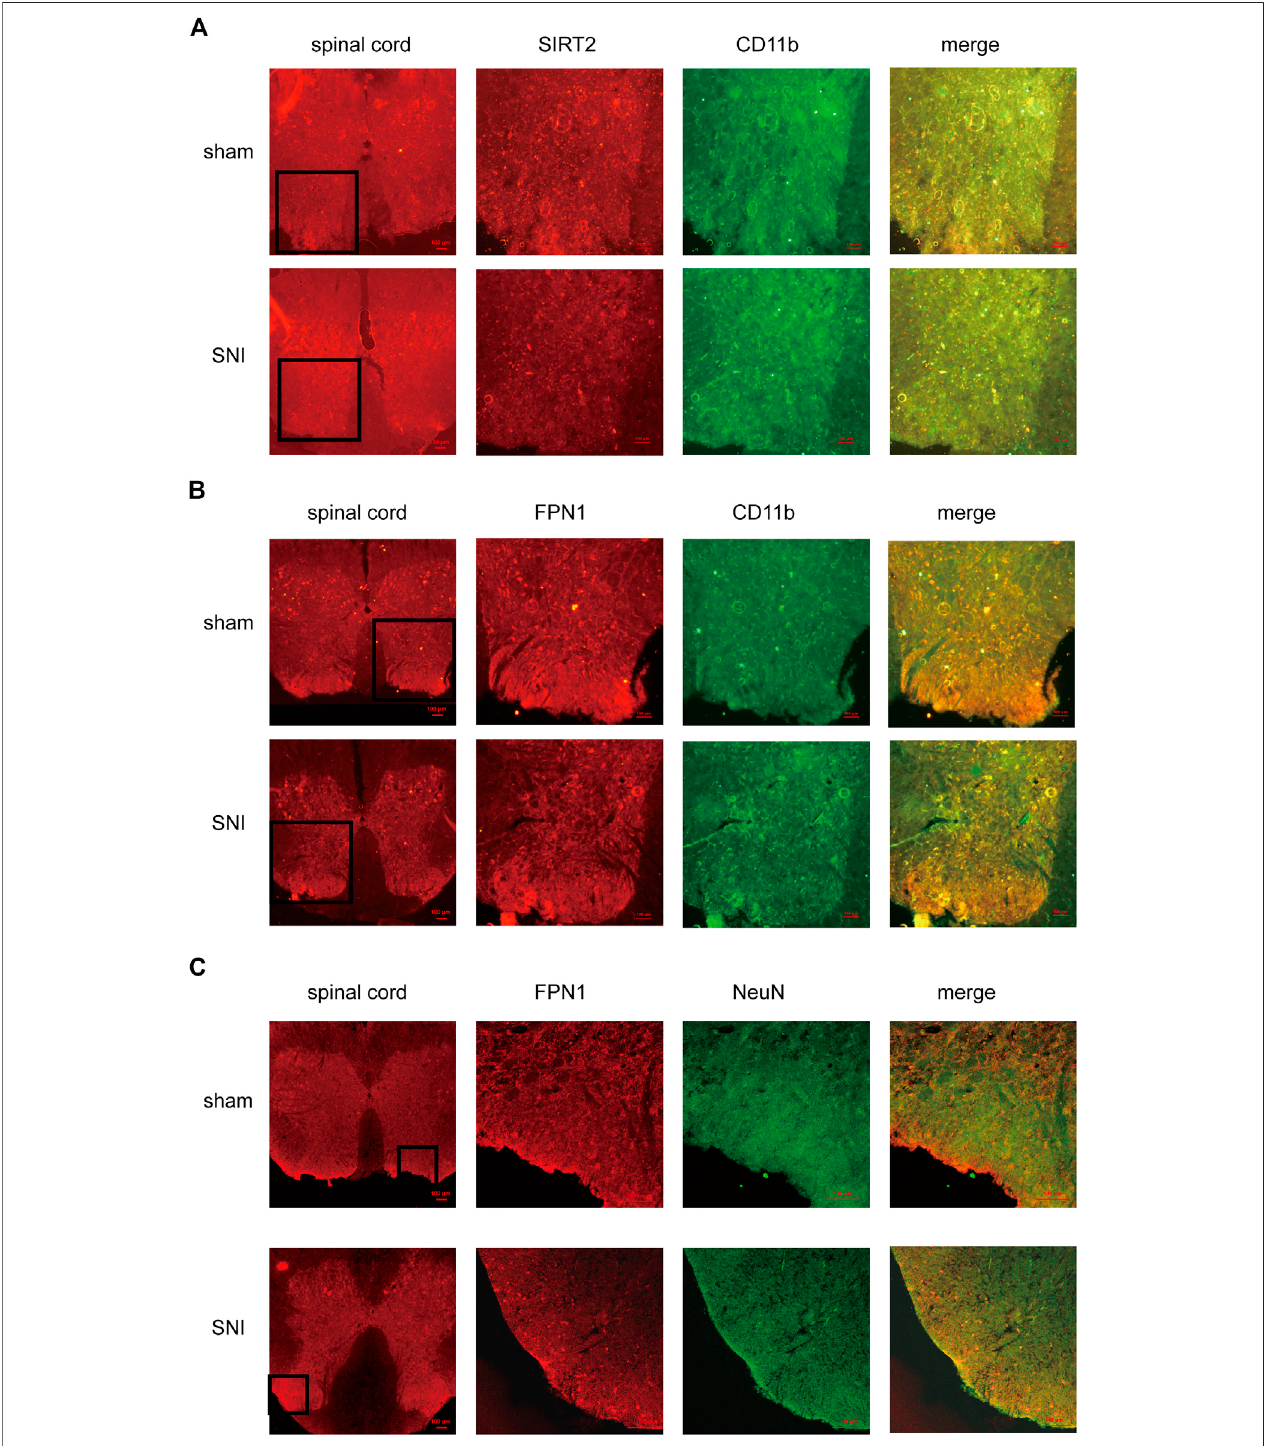
FIGURE3| ThecellularlocalizationofSIRT2andFPN1inthespinalcord. (A) SIRT2levelsdecreasedinthemicrogliaofSNIrats. (B , C) FPN1levelsdecreasedinthe microgliaandneuronsofSNIrats.Theimageinthe fi rstcolumnontheleftshowstheoveralloutlineofthespinalcord.Representativeconfocalimagesshowtheresultsof doubleimmuno fl uorescencestainingofSIRT2orFPN1(red) inthespinaldorsalhorn;CD11b, amicrogliamarker(green)orNeuN,aneuronalmarker(green)inthesham group and SNI group. Scale bars, 100 μ m. SNI, spared nerve injury; SIRT2, sirtuin 2; FPN1, ferroportin 1.